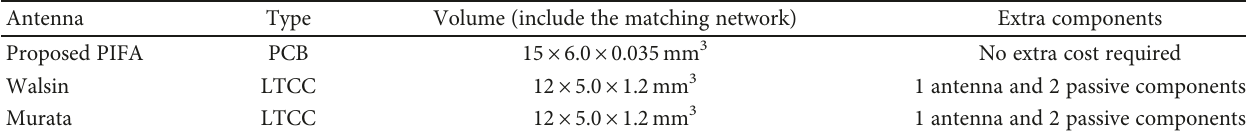
Table 3: Comparison between proposed PIFA, Walsin [12], and Murata antennas [14].